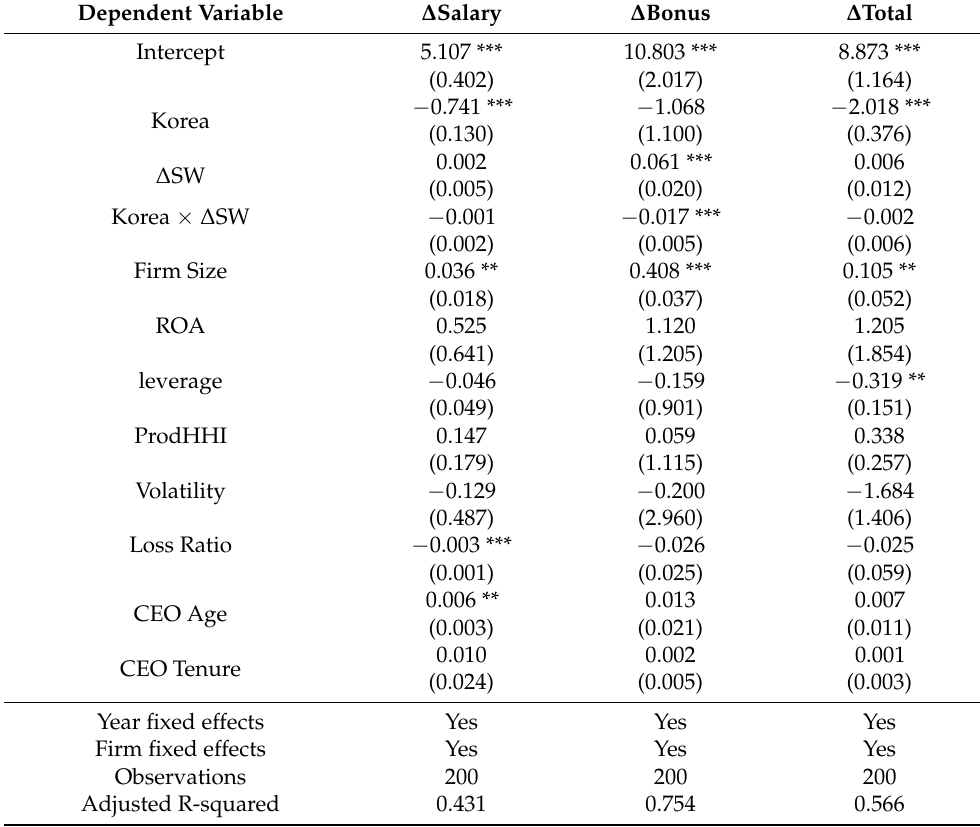
Table 8. Comparison of Compensation-performance Sensitivity using the Bootstrap